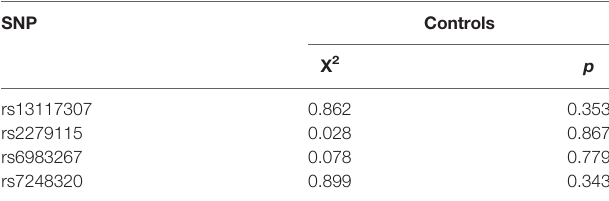
TABLE 1 | Hardy-Weinberg equilibrium test results of target SNPs in controls.